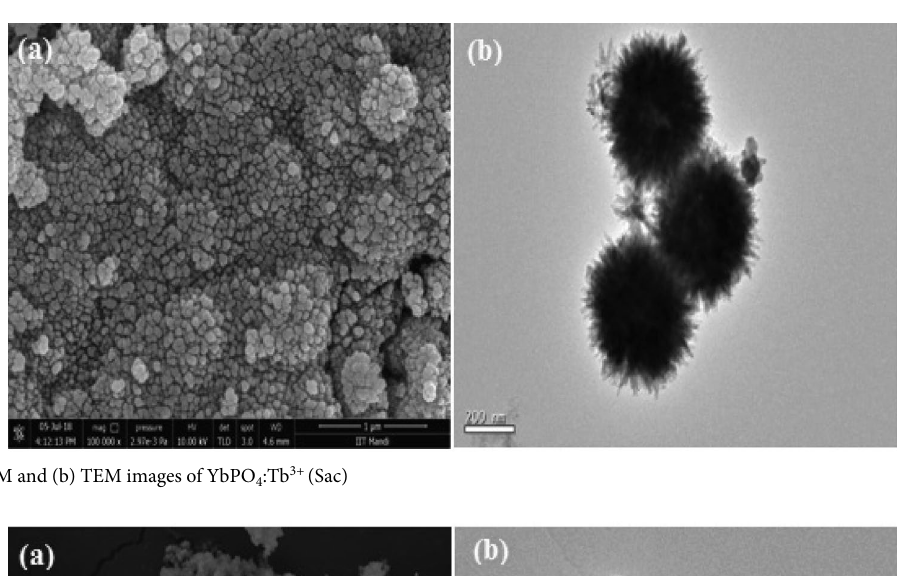
Khajuria et al.: Studies on Morphology and Photoluminescent ...